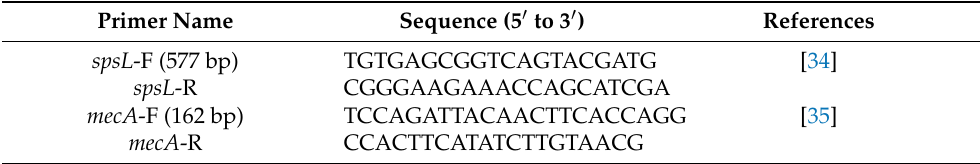
Table 4. Primer sequences of the spsL and mecA genes used for polymerase chain